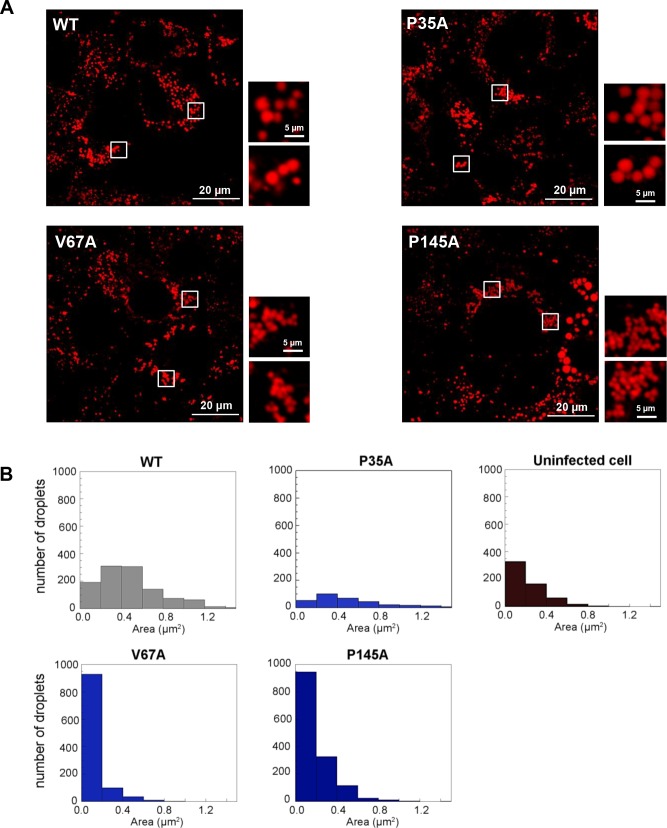
Quantification of the effect of the V67A and P145A mutations on the size of LD.A LDs in Huh7.5 cells electroporated with the indicated JFH-1 constructs were visualized by staining with BODIPY 558/568-C12. B The size of individual LD was determined and plotted as a histogram. The area (μm2) is taken as an indication of the three-dimensional volume of the LD. For comparison similar data was determined from uninfected Huh7.5 cells.